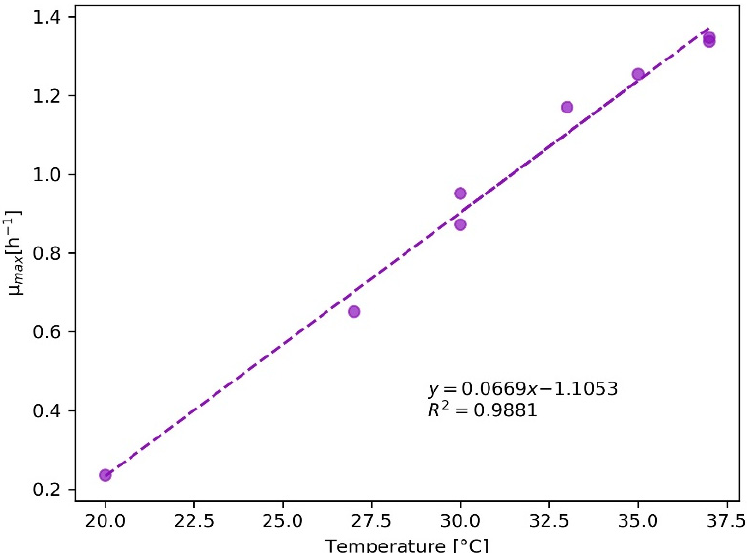
Figure A2. Dependence of growth rate on temperature in a E. coli cultivation (20 to 37 °C, 200 rpm, 25 mm shaking amplitude, 40 mL TB medium in 500 mL baffled shake flasks). The growth rates were calculated with online OUR data.